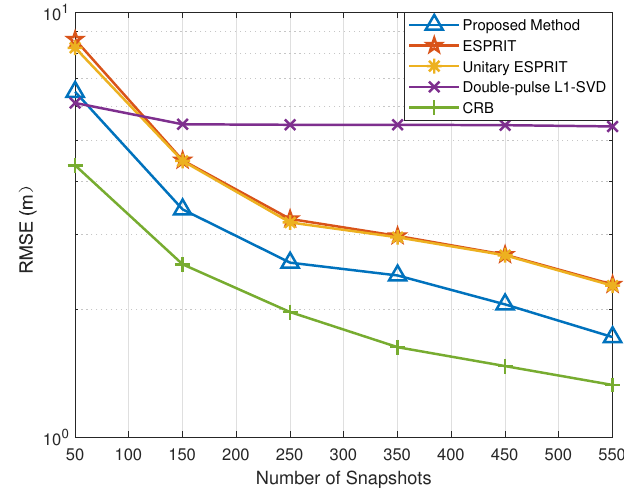
Figure 6. RMSE of range estimation versus